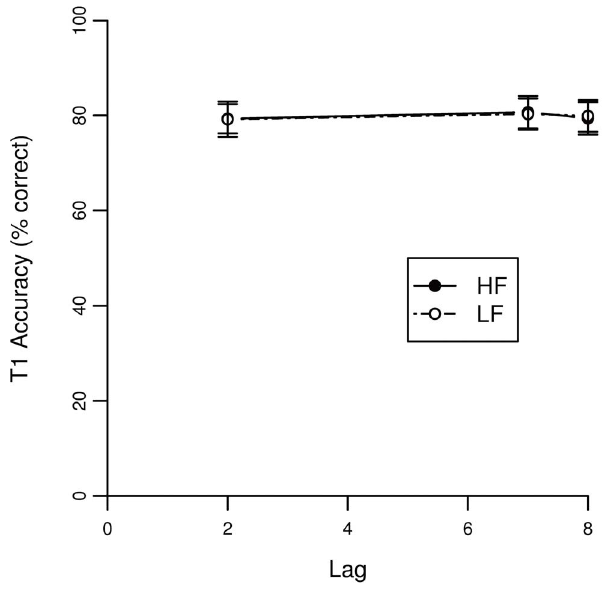
Figure 5. Accuracy scores of the AB task as produced by the model on lag 1, 2 and 7 for T2 given T1 correct. The lag corresponds to the temporal location of T2 relative to T1.